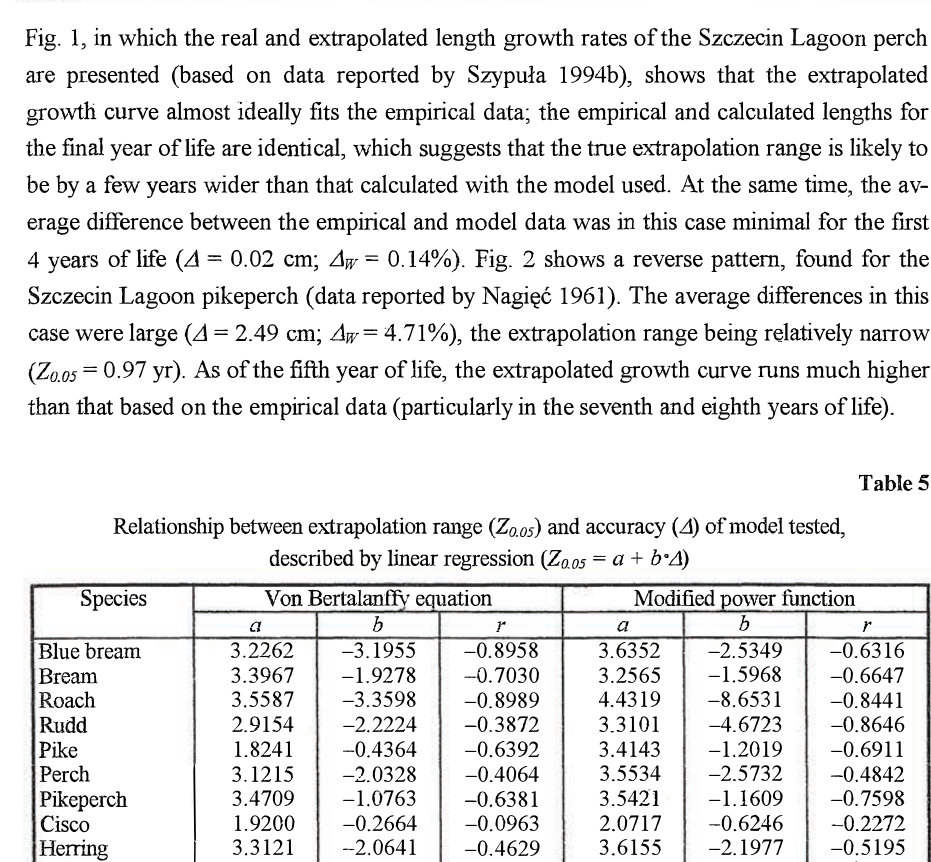
Relationship between e>..irapolation range (Z0_ 05 ) and accuracy (Li) of model tested, described by linear regression (Zo.os =a+ b 0 L1)